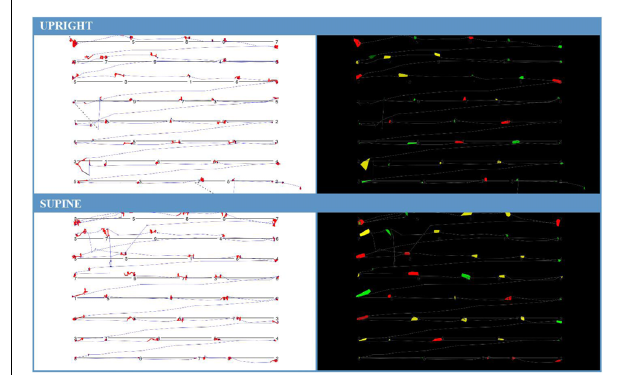
FIGURE 3 | Card one of the KD infrared eye tracking test for Participant 1. Image ( A , top) is participant in loaded or upright position. ( B , bottom) is participant in acute unloaded or supine position. (A) (loaded) completion time for card one: 20.192 s, average fixation time: 367 ms, average saccade velocity: 218 deg/s. (B) (acute unloaded) completion time for card one: 20.229 s, average fixation time: 403 ms, saccade velocity: 215 deg/s.